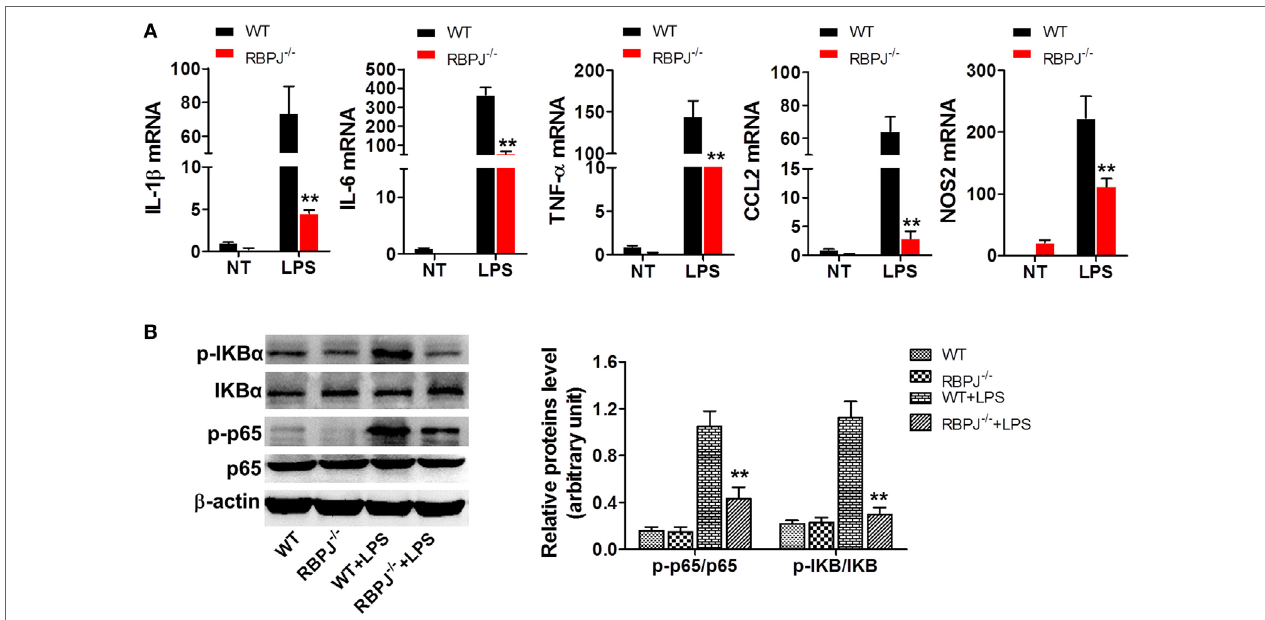
FigUre 7 | RBP-J knockout led to decreased inflammation in macrophages. (a) RBP-J − / − and wild-type (WT) macrophages were stimulated with lipopolysaccharide (LPS) and then RT-PCR was used to assess the levels of IL-1 β , IL-6, TNF- α , CCL2, and NOS2. (b) RBP-J − / − and WT macrophages were treated with LPS or PBS and then the phosphorylation levels of p65 and I κ B α were examined through Western blotting. ** p < 0.01 compared with LPS + WT group; n =